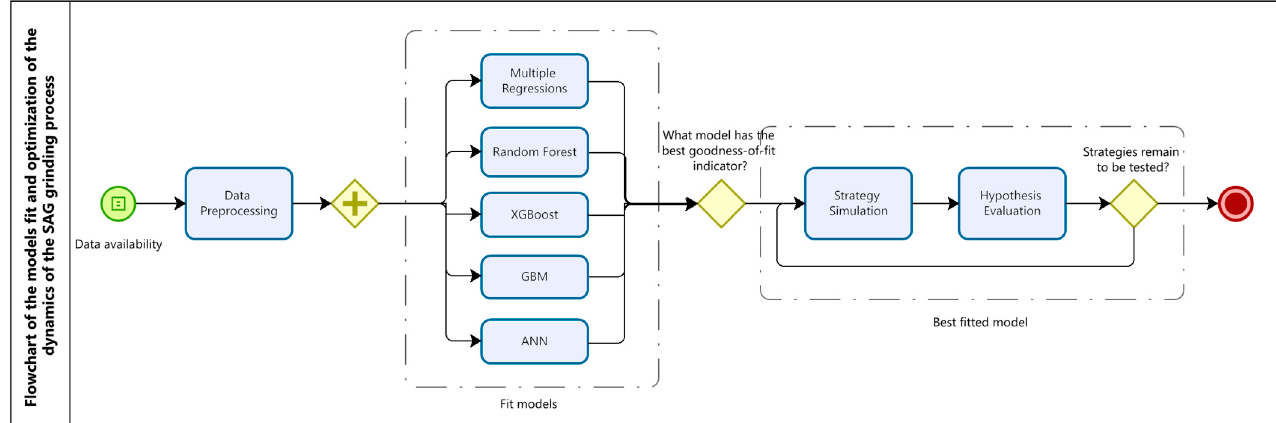
Figure 2. Flowchart of the model’s fit and optimization of the dynamics of the SAG grinding process (developed in Bizagi Modeler software [97]).